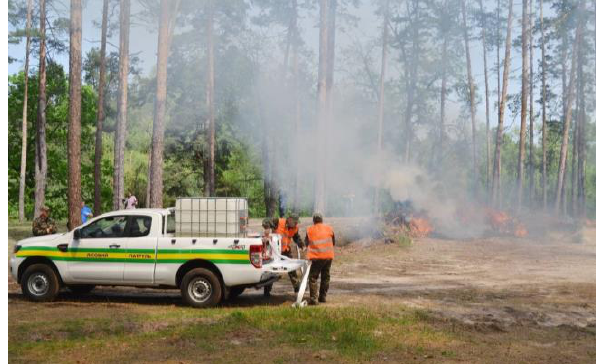
Fig. 2. The most common fire engine in a typical forest fire station in Ukraine (AT-40 on the chassis ZIL-131. Paryshiv Fire Station, Chernobyl Exclusion Zone)